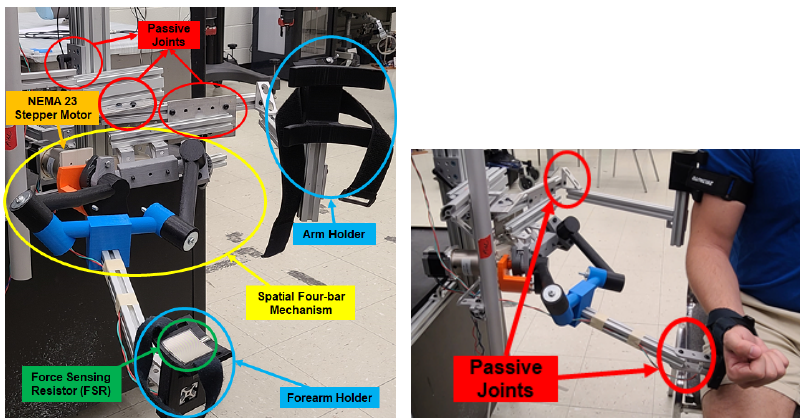
Figure 3. Task-based exoskeleton prototype.